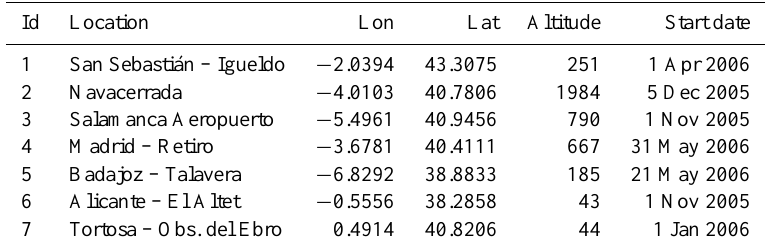
Table 2. Weather stations from the AEMET network used in this study. Their location is indicated on the first map of Fig. 1. Position in decimal degrees and m above sea level (WGS84).